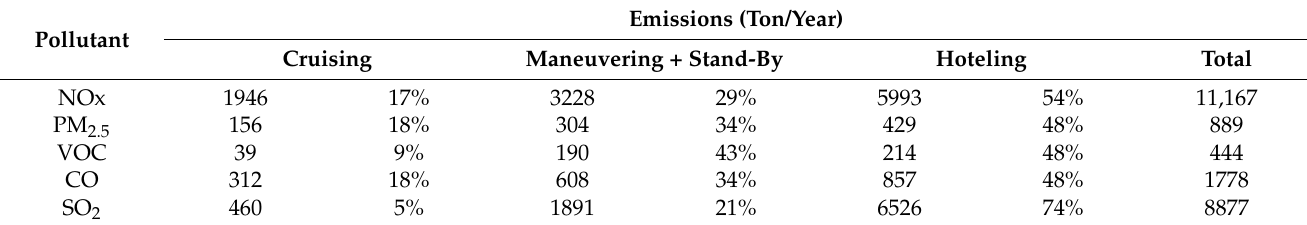
Table A9. Total emissions from vessels (Haifa, 2018).